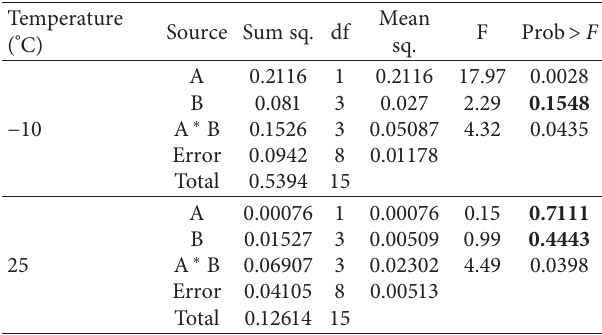
Table 7: Two-way ANOVA results of specimens at different